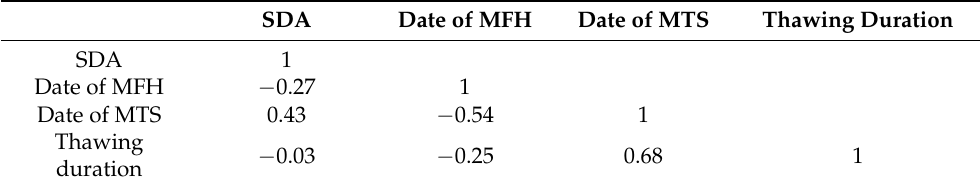
Table 4. The correlation coefficient between seasonal deformation characteristics.